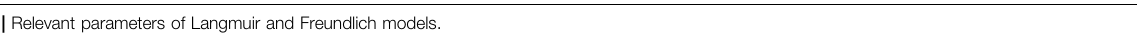
TABLE 2 | Relevant parameters of Langmuir and Freundlich models. Langmuir Freundlich Temperature ( K ) q e, exp (mg/g)